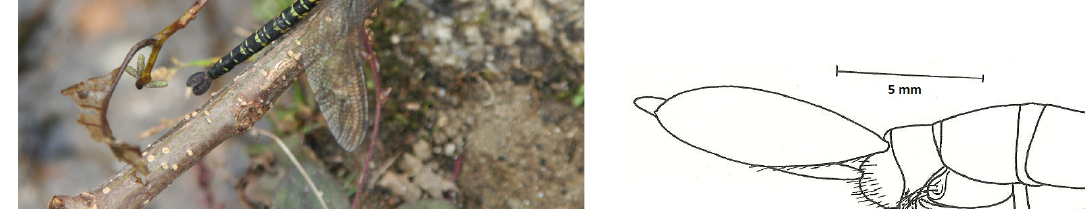
Figure 1a. Dorsal view of abdominal markings and anal appendages of female Aeshna